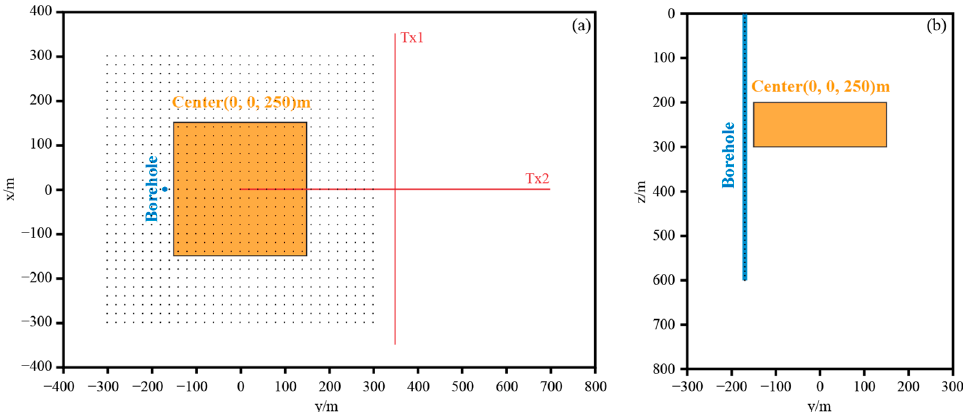
Figure 3. A synthetic model. ( a ) Plane view at z = 250 m; ( b ) cross section at x = 0 m. The orange blocks show the anomalous body. The two red lines denote the transmitting sources, while the blue dot at the left figure and the blue line at the right figure denote the borehole. The black dots at the left and right fi gures denote the receiver locations.